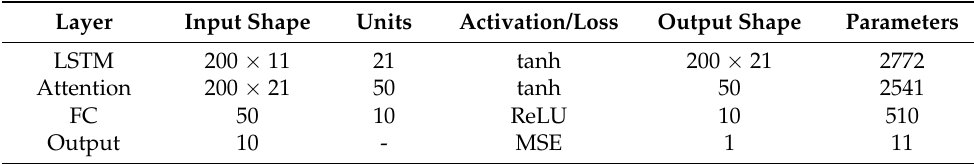
Table 1. Parameter setting of attention-based LSTM